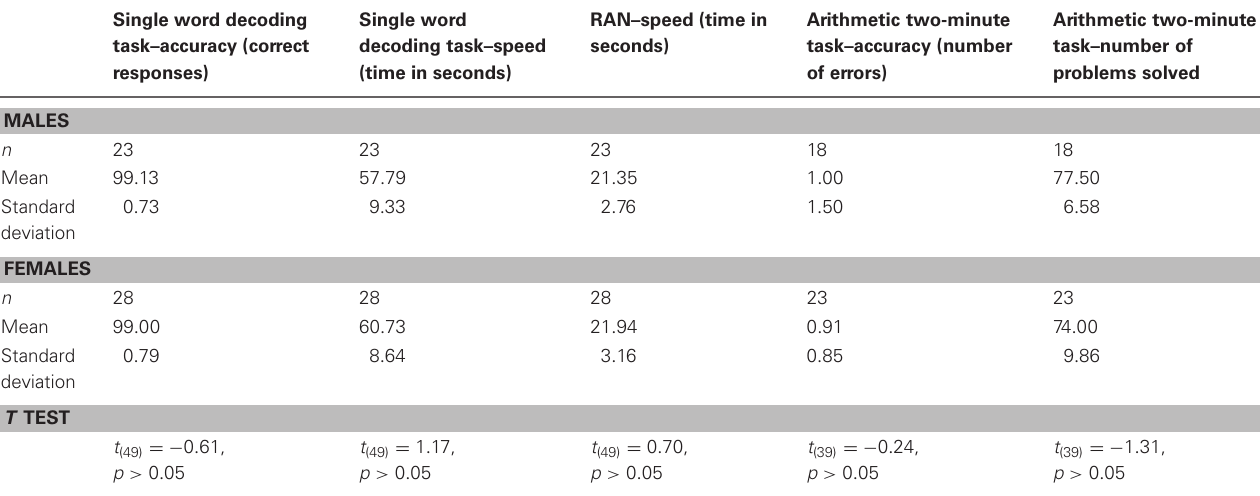
Table 1 | Gender differences based on classification